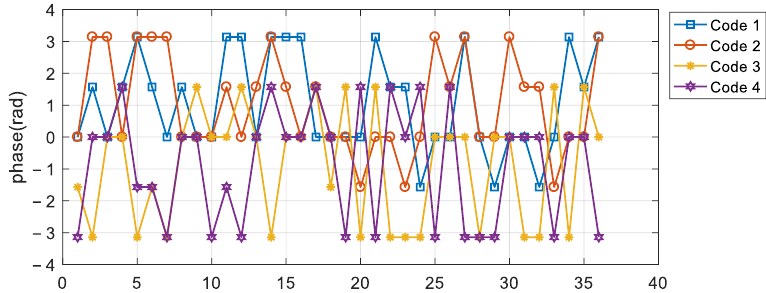
Figure 3. Example of orthogonal quadratic phase codes of length of 36.